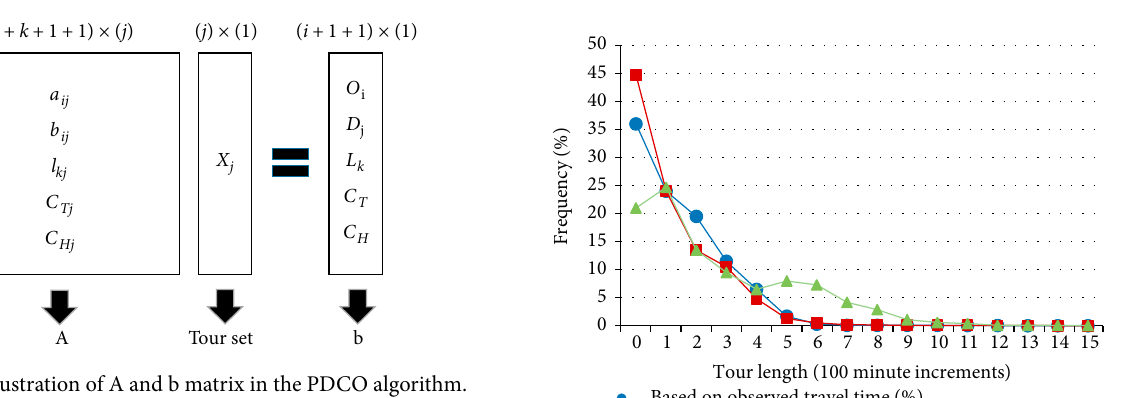
Figure 7: Illustration of A and b matrix in the PDCO algorithm.